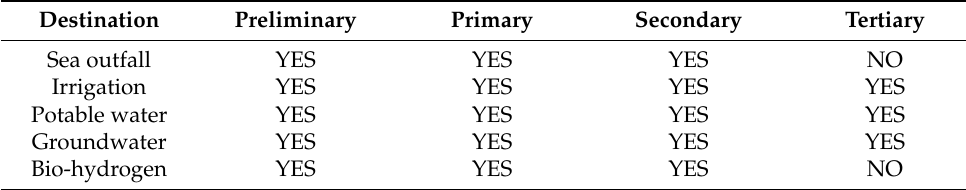
Table 1. The main treatment stages and categories of